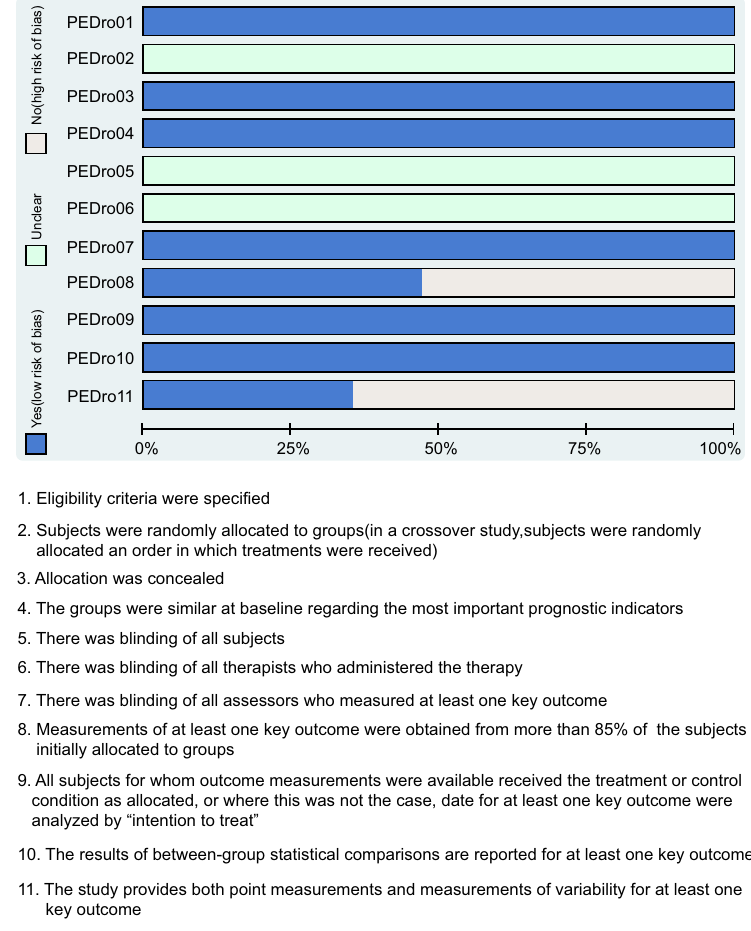
Fig 1. Quality assessment based on PEDro scale of clinical controlled trials included in the network meta-analysis. Note: PEDro = Physiotherapy Evidence Database.